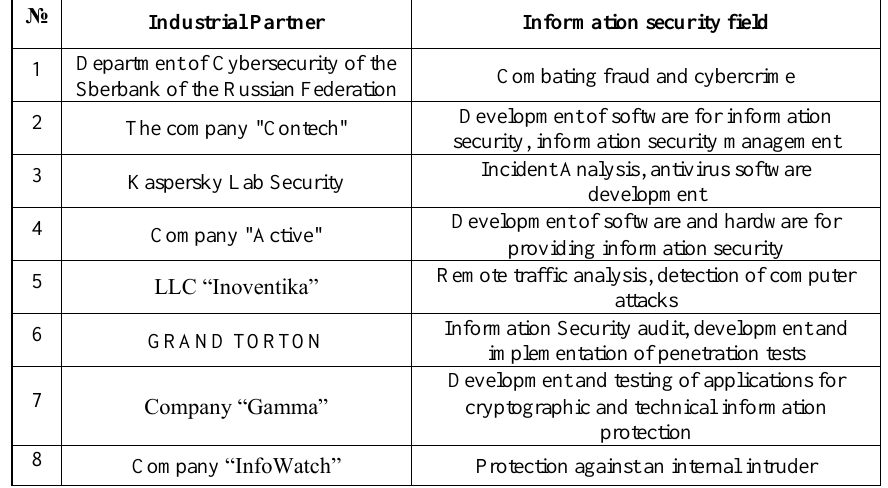
Table 2. The industrial partners in the cyber